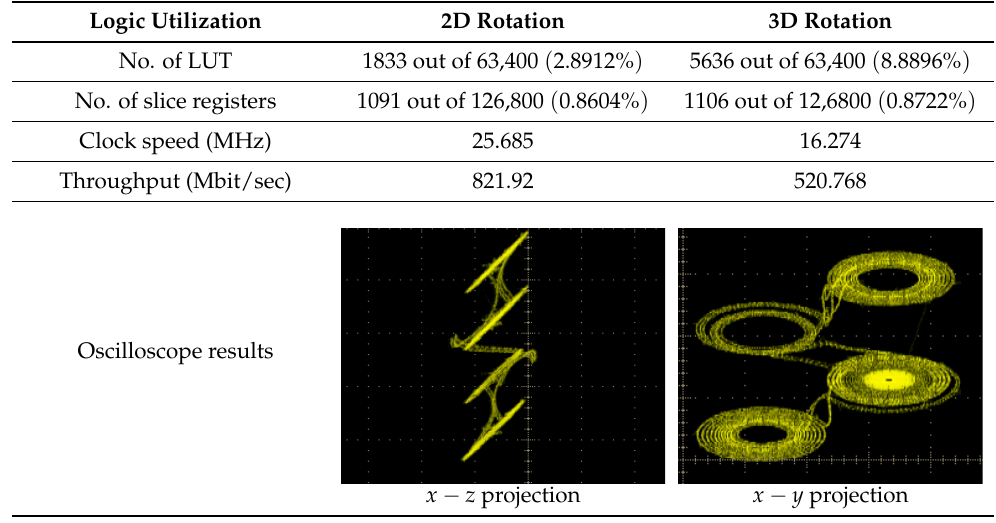
Table 4. FPGA summary and experimental results for the fractional-order multi-scroll